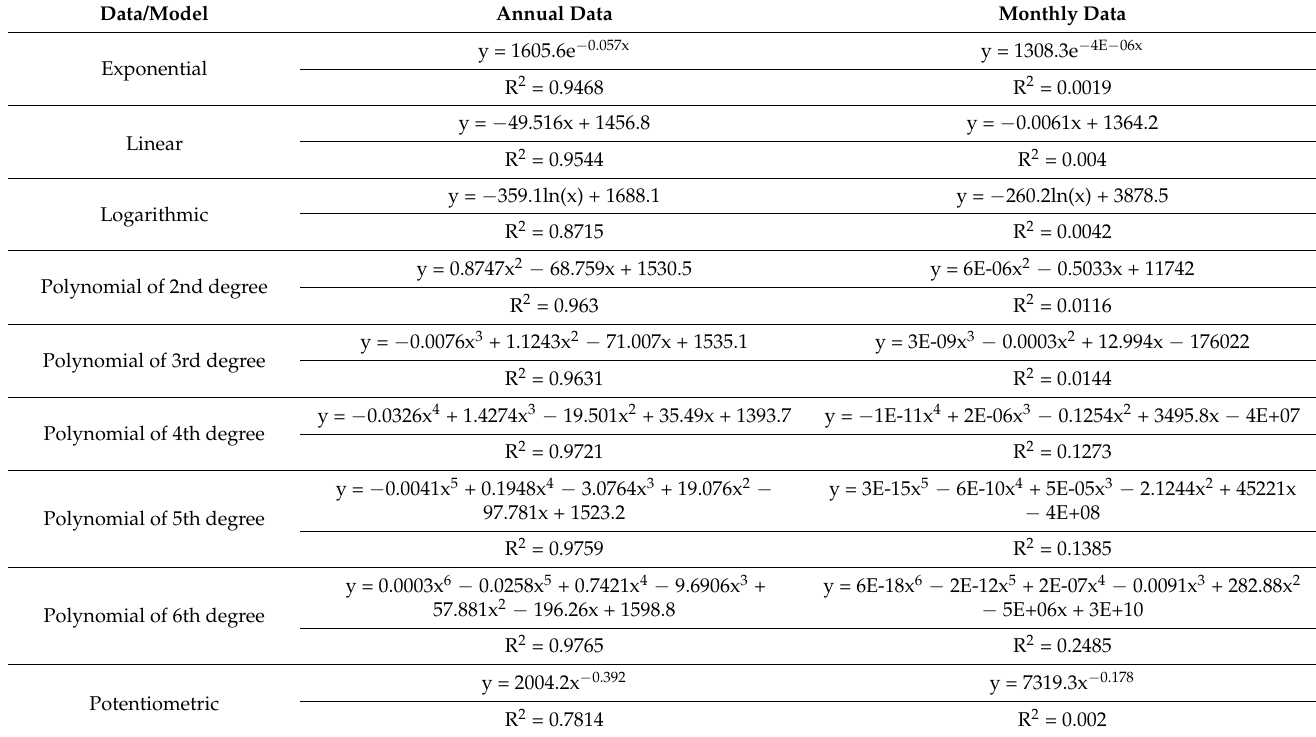
Table A10. Trend models for Podlaskie province.